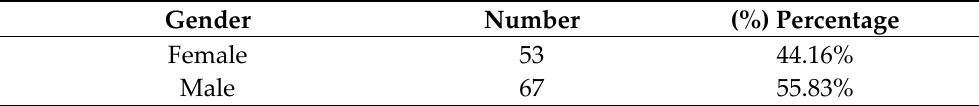
Table 2. Distribution of participants according to their